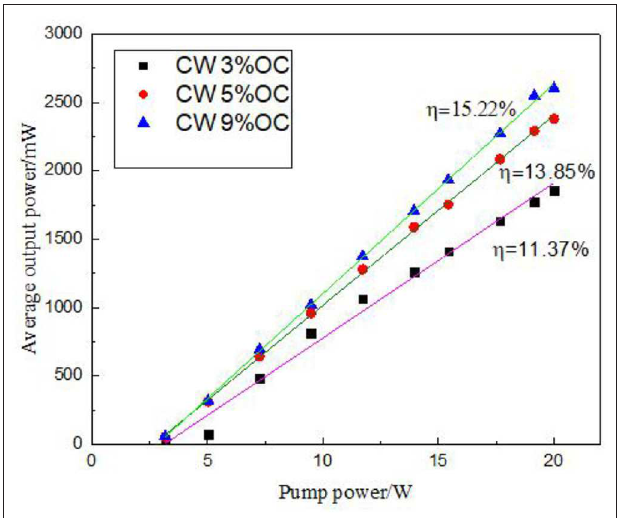
FIGURE 6 | The emission spectrum of the mode locking laser.